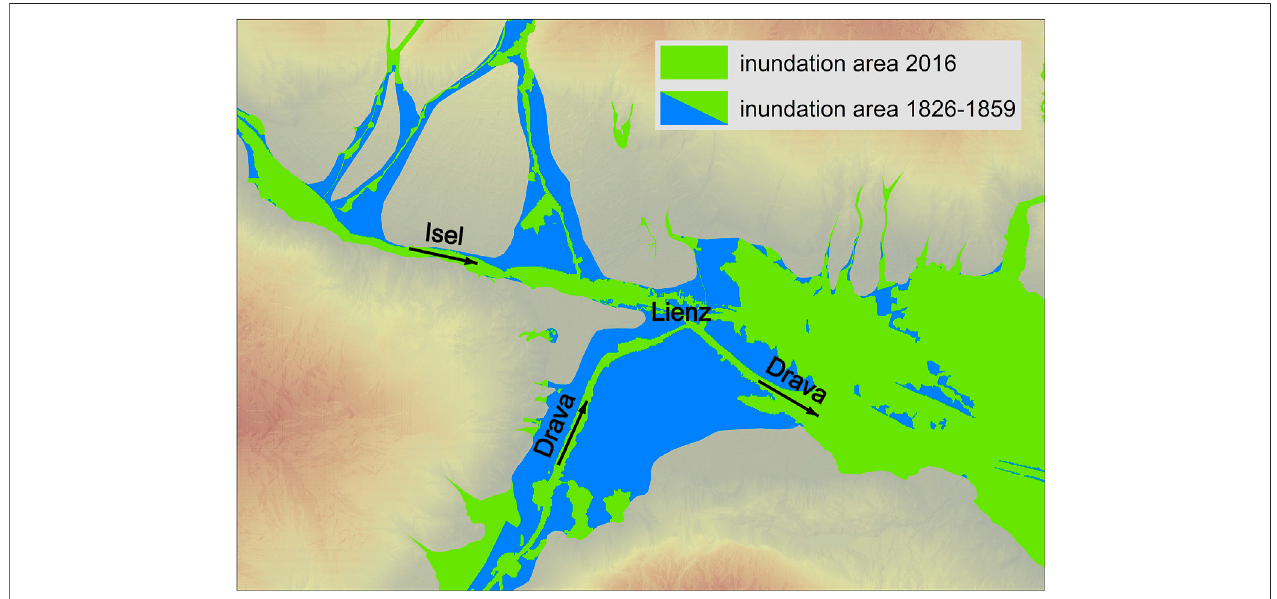
FIGURE 5 | Fluvial corridors close to the town Lienz in Eastern Tyrol, where the tributary Isel joins the Drava River. Current inundation areas at approximately 300- year fl oods(green)areoverlaidover historicalones(blue).Torrent regulationsigni fi cantlyreduced fl ood-proneareas alongthetributariesoftheIselRiver.Riverregulation and fl ood protection measures substantially truncated former inundation areas upstream of Lienz (see location of the detail in Figure 4 ).